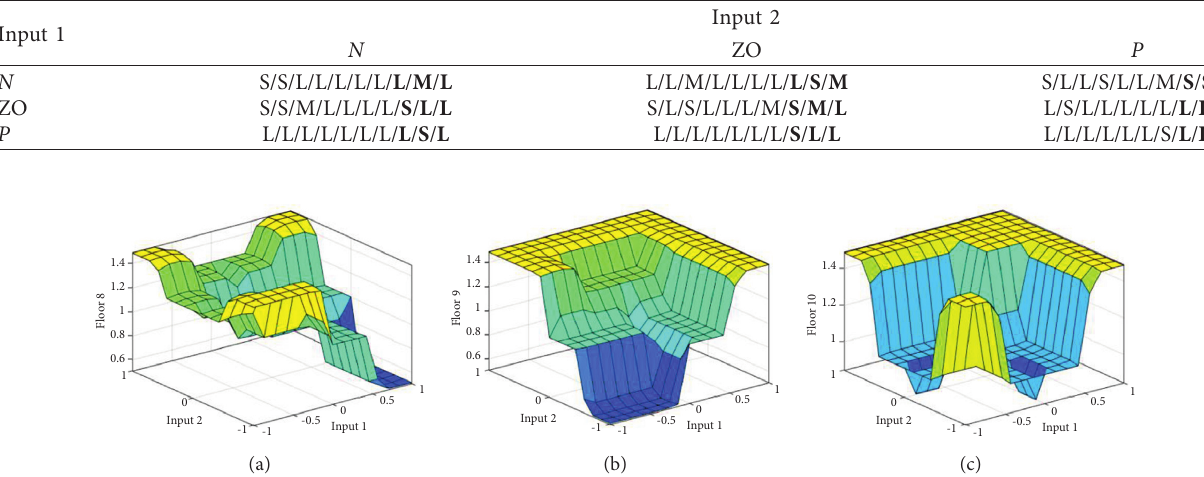
Table 7: Fuzzy inference rule base.